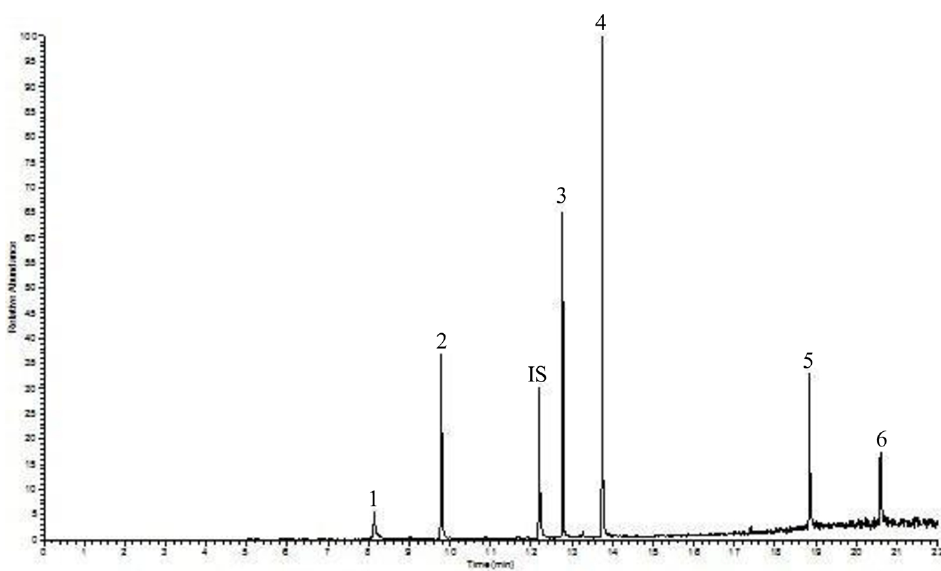
Figure 5. GC-IT/MS chromatogram of PAEs obtained by analyzing a real sample of blood from Caretta caretta turtle. The graph reported the relative abundance ( y axis) as function of the time in min ( x axis). Peaks: 1—DMP; 2—DEP; 3—DiBP; 4—DBP; 5—DEHP; 6—DnOP; IS (Internal Standard)—phenanthrene. For experimental conditions: see text.